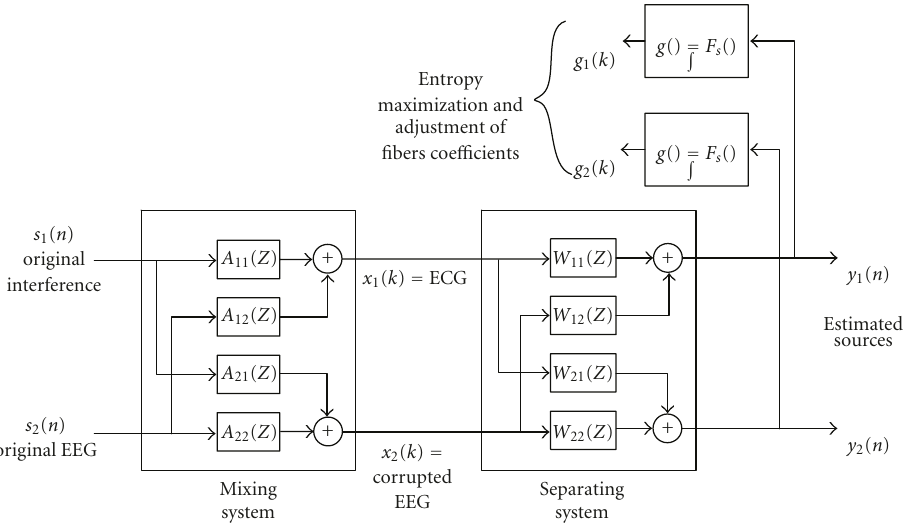
Figure 10: Network architecture for ICA based on the maximization of the joint entropy.